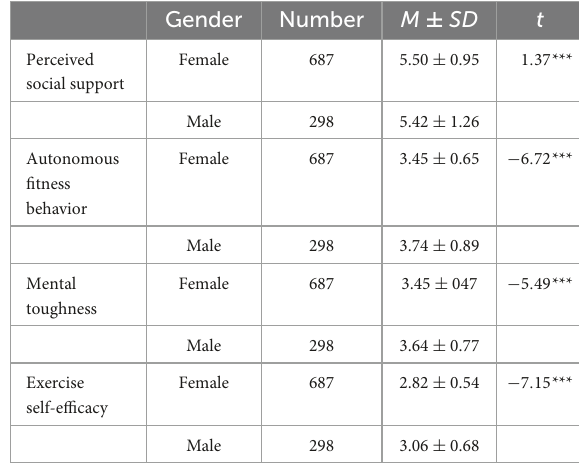
TABLE 2 Differences in